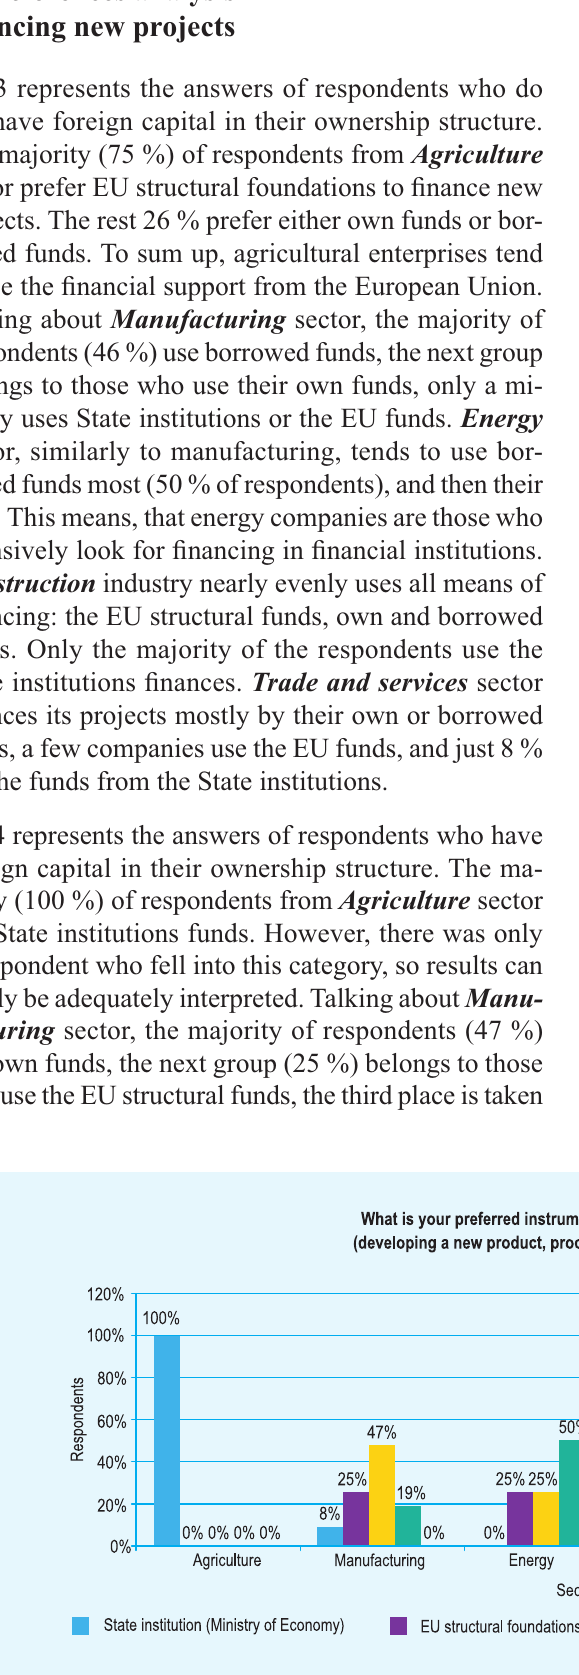
Fig 4 . Preferred instruments to fi nance new projects for businesses with